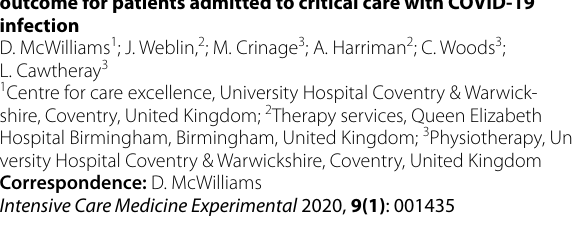
Table 1—Relationship between MMS at ICU discharge and discharge